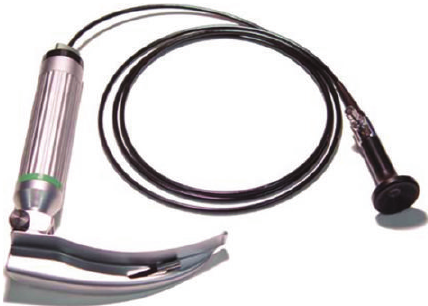
Figure 1: Lary-Flex videolaryngoscope (source: manufacturer mar- keting materials).